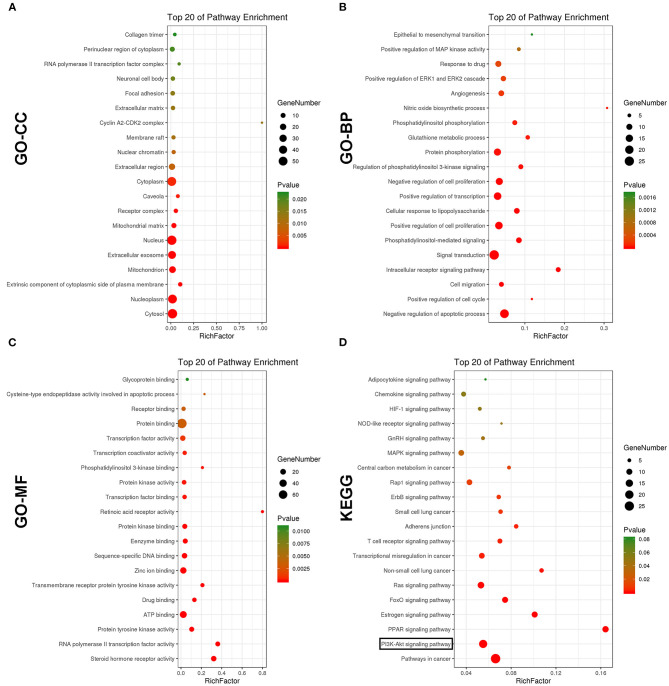
GO and KEGG analyses. The top 20 signaling pathways of PTL in GO-Cellular Component analysis (A). The top 20 signaling pathways of PTL in GO-Biological Process analysis (A,B). The top 20 signaling pathways of PTL in GO-Molecular Function analysis (C). The top 20 signaling pathways of PTL in KEGG pathways analysis (D).